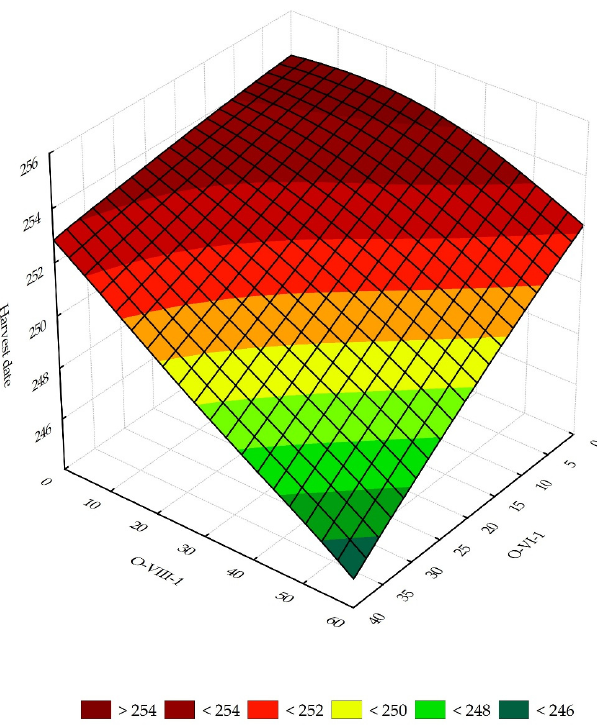
Figure 3. The response surface for the harvest date and two variables, O-VII-1 and O-VI-1.